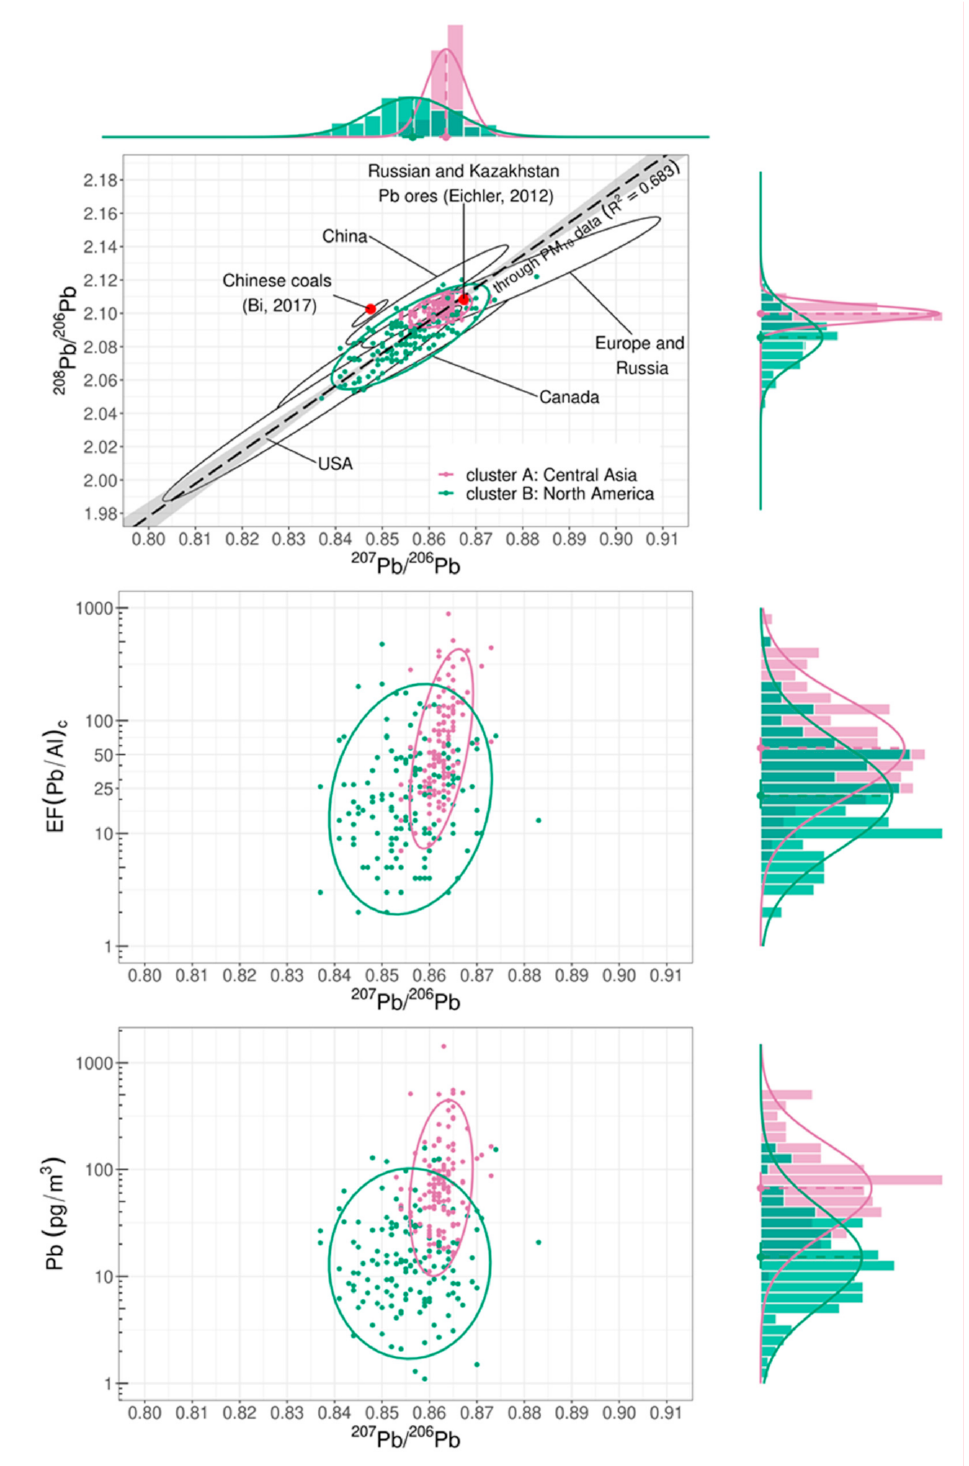
Figure 2. Result of the Gaussian Mixture Modeling for Pb isotope ratio values, enrichment factors (EFs), and Pb concentration measured in PM 10 samples collected at Ny-Ålesund from 2010 to 2018 represented in a three-isotope plot. The regression line for PM 10 data was obtained by Deming regression, considering an uncertainty on 208 Pb/ 206 Pb values double in comparison to 207 Pb/ 206 Pb values. Data for Russian and Kazakhstan Pb ores: [43], data for Chinese coals: [46]. Black ellipses represent the joint-distribution (95% confidence level) of literature data. Canada and USA: [22,38], Europe: [21,22,39] Russia: [21,22], China: